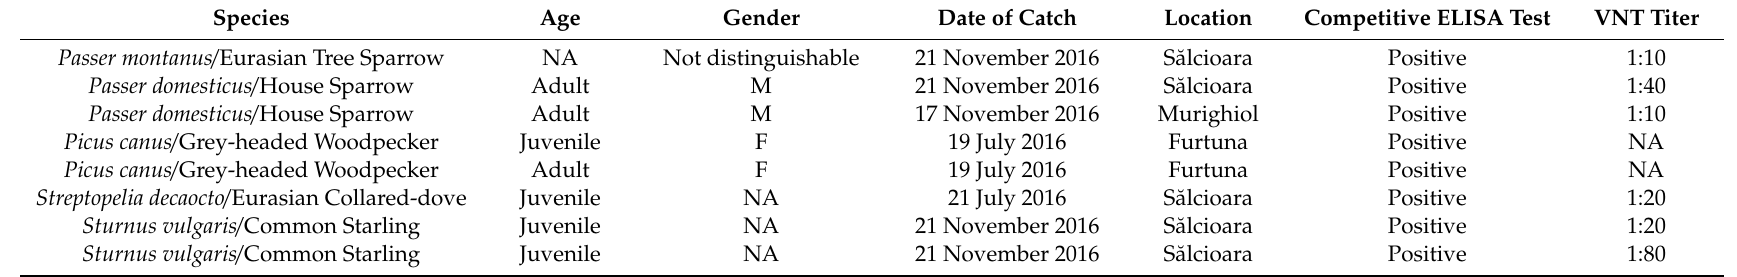
Table 1. Wild birds from Danube Delta Biosphere Reserve that tested positive for West Nile virus (WNV) by competitive ELISA and corresponding Virus Neutralization Test (VNT) results.